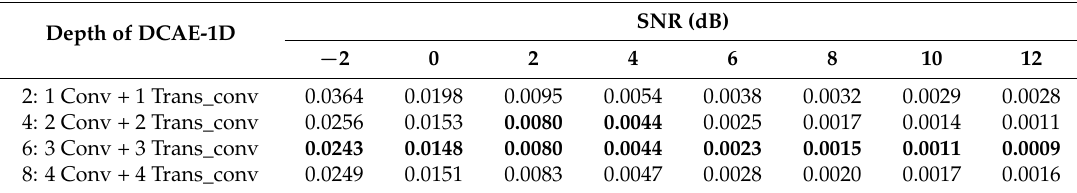
Table 9. Diagnosis accuracy (%) of AICNN-1D with different kernel width of the first convolution layer.